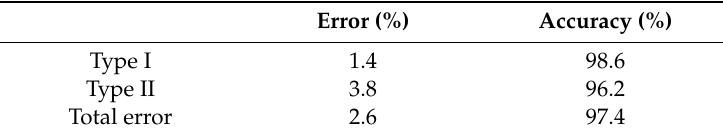
Table 4. Default and errors of SOM